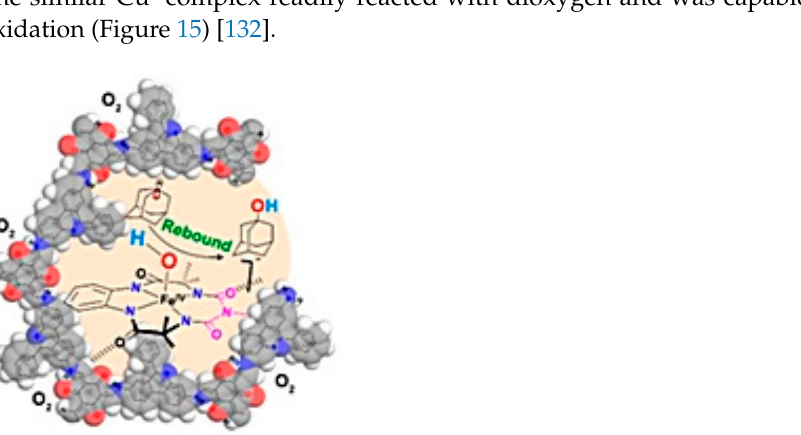
Figure 14. C-H functionalization in water via the stabilized Fe IV =O intermediate in the cavity of a COF nanosphere. Adapted with permission from (Sasmal et al., 2021) [128]. Copyright 2021 American Chemical Society.